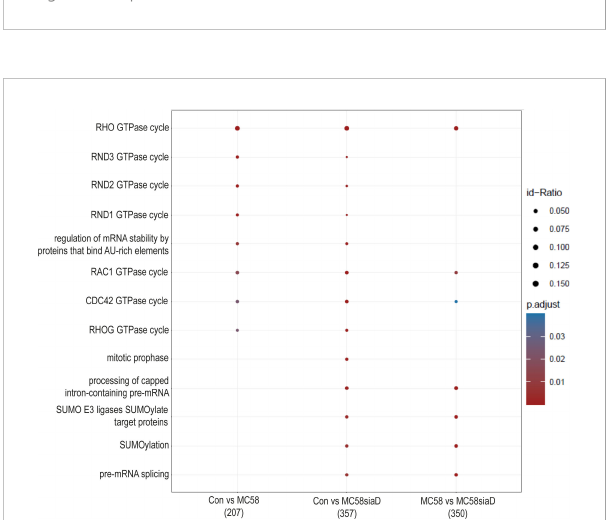
FIGURE 6 Pathway enrichment analysis after infection with N. meningitidis